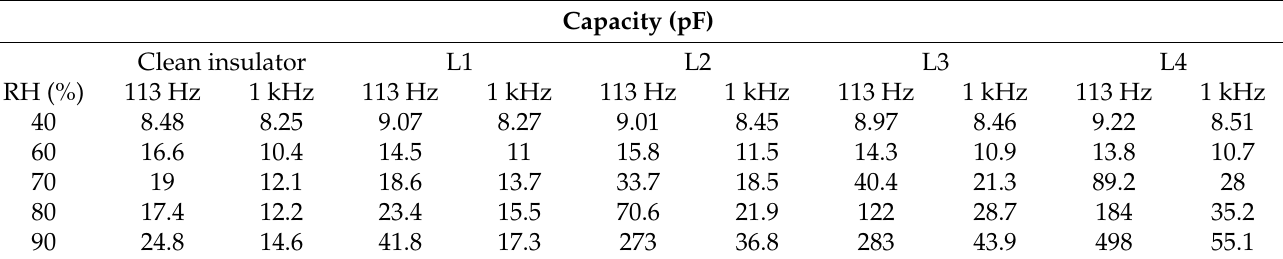
Table 5. Capacity measured data at frequencies 113 Hz and 1 kHz.